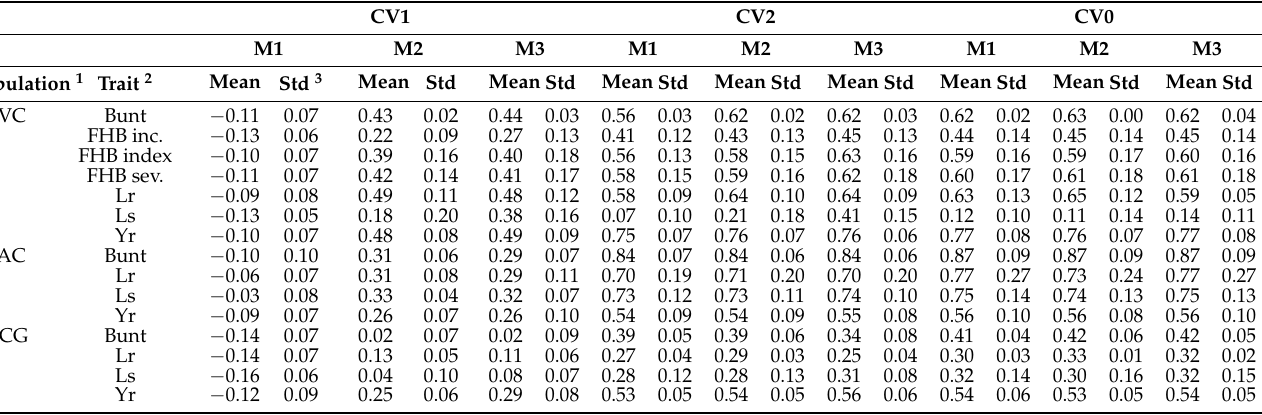
Table 2. Mean prediction accuracies obtained using three random cross-validation schemes (CV1, CV2, and CV0) and three models (M1, M2, and M3). See Table S5 for details of prediction accuracies. CV1 CV2 CV0 M2